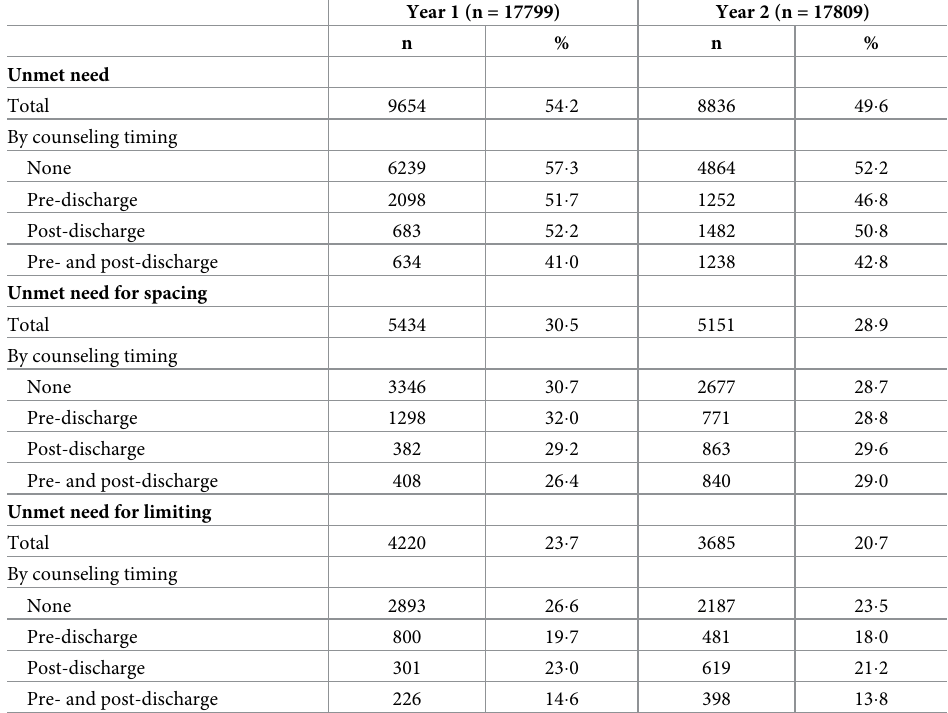
Table 2. Number and percentage of women with unmet need for modern